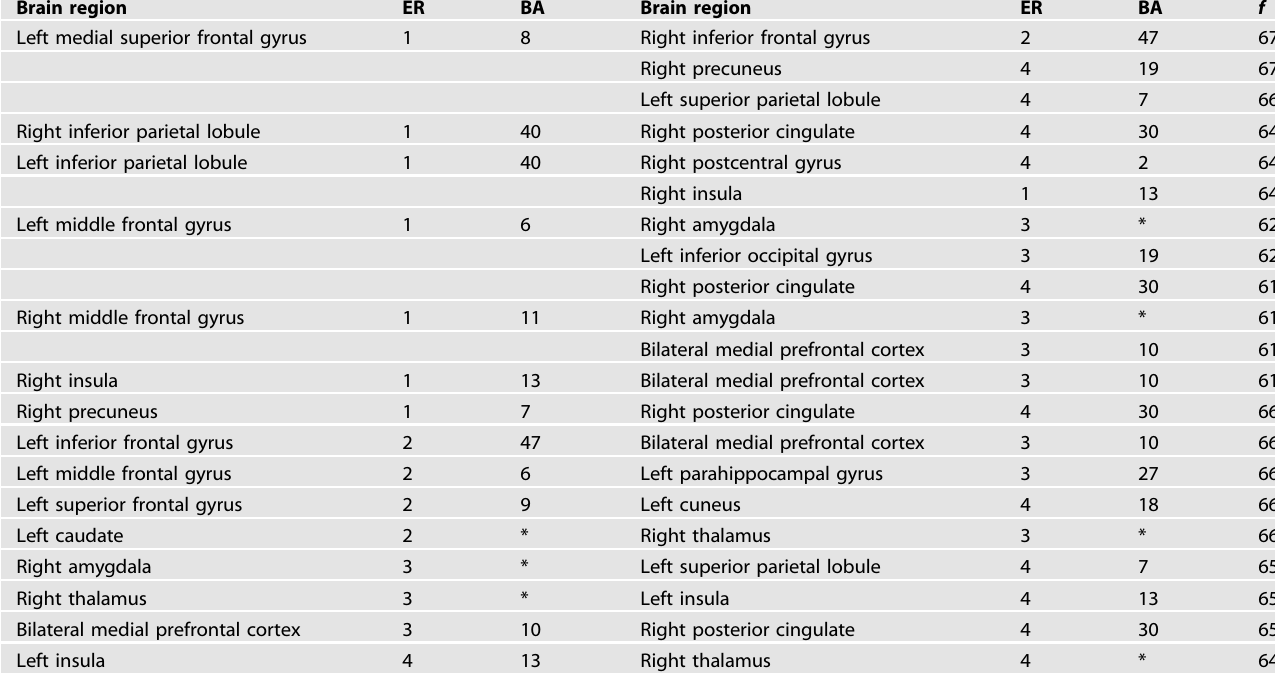
Table 2. Consensus features in the prediction model.